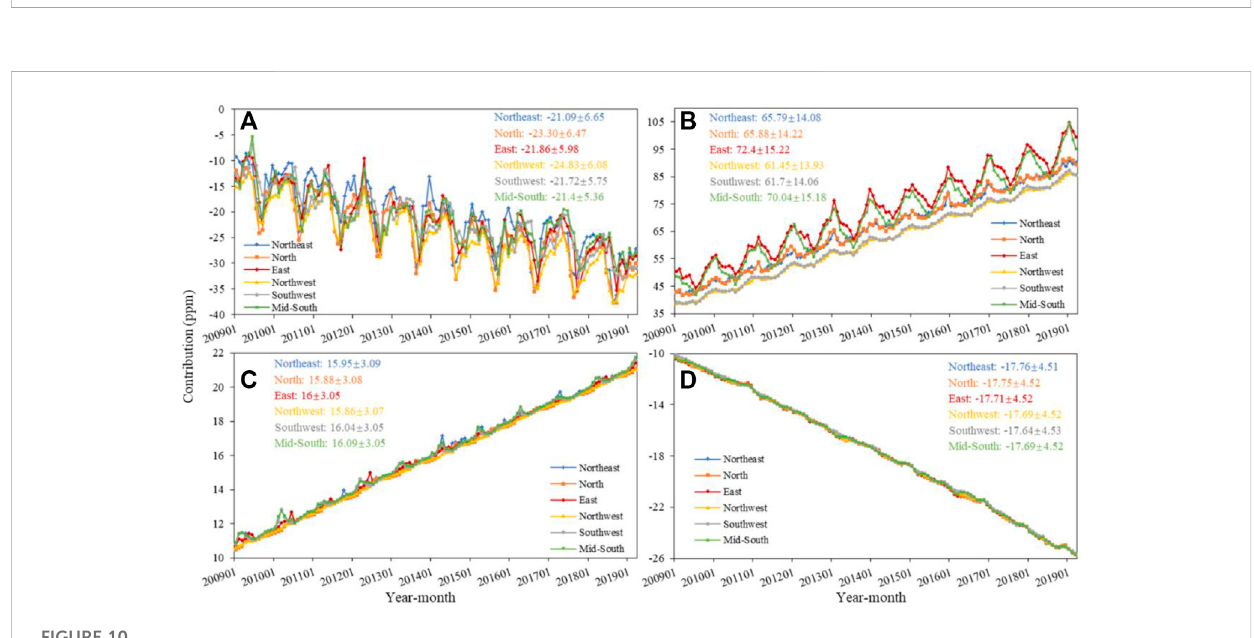
FIGURE 10 Simulated CO 2 from biogenic (A) , anthropogenic (B) , fi re (C) , and oceanic (D) modules in CT at near